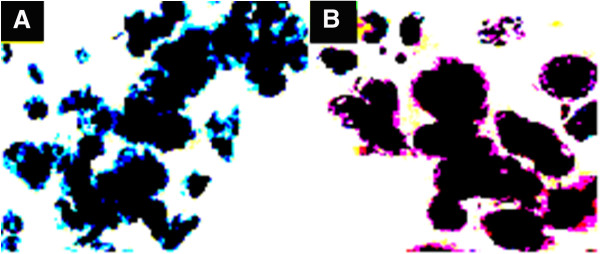
(A) Fine-needle aspiration of thymoma showing predominately round to oval cells with moderate nuclear atypia in type AB thymoma. Note thick nuclear membranes and more prominent nucleoli. (B): High power view of type AB thymoma .Marked pleomorphism characterized these cells. Few lymphocytes are present.